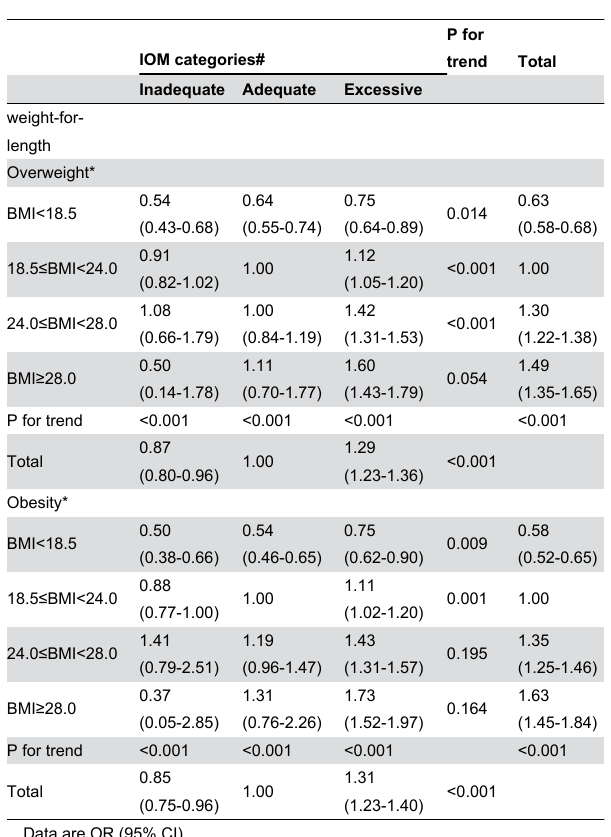
Table 4. Relative risk of childhood overweight and obesity at age 12 months stratified by maternal gestational weight gain and pre-pregnancy body mass index. Table S1. Comparison of Z scores for body weight, body